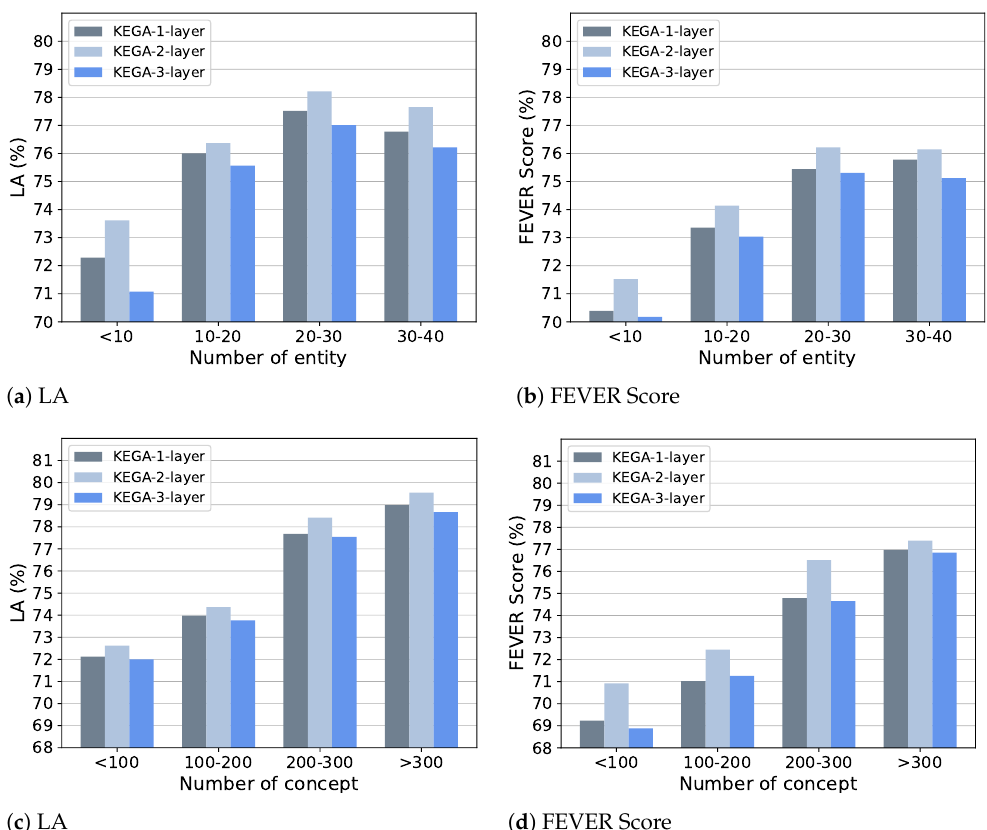
Figure 5. Effect on performance of KEGA variants in terms of label accuracy and FEVER Score (%) with different number of entities and